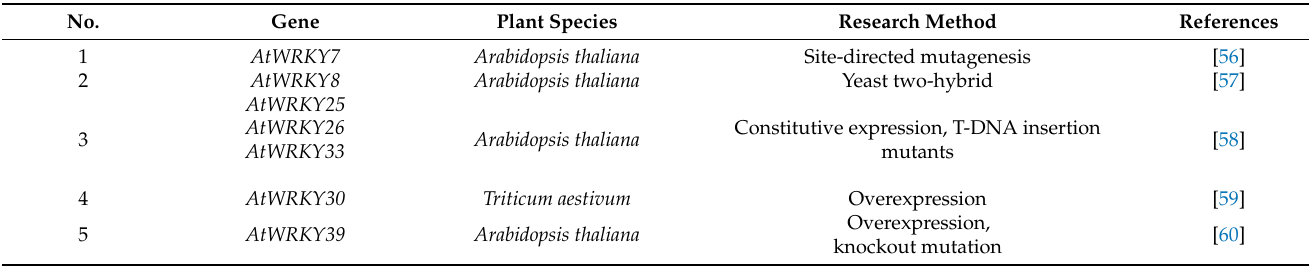
Table 1. WRKY transcription factors partially respond to high-temperature